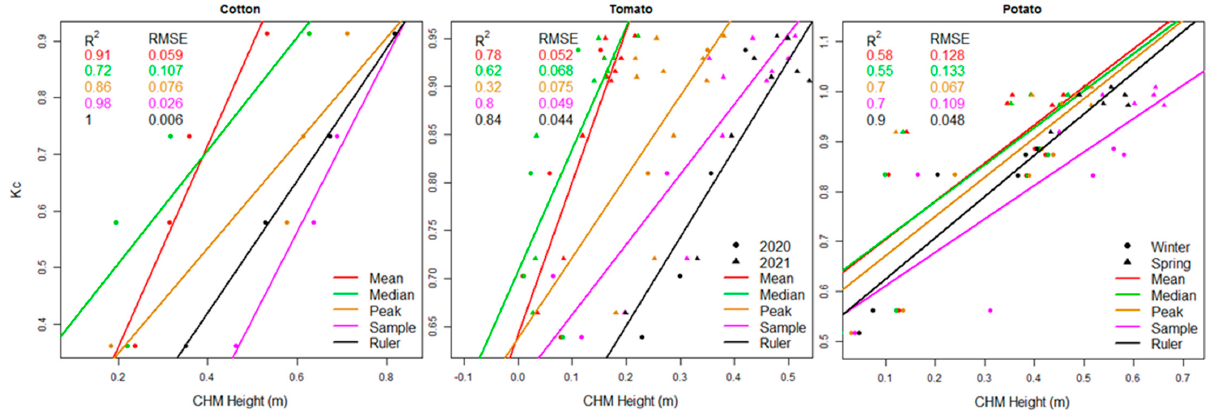
Figure 7. Linear regressions between the crop height models (CHMs), the manual ruler measurements, and the crop coefficient (K c ).